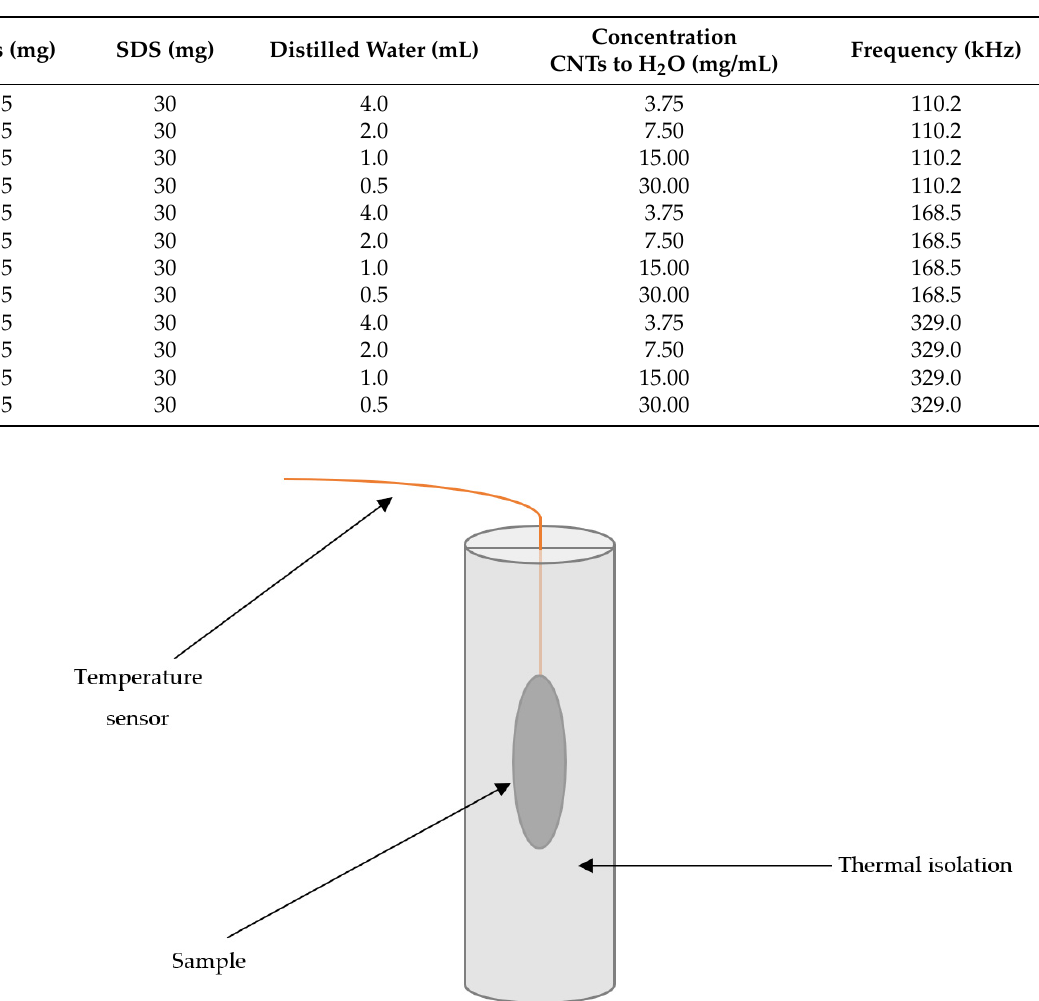
Table 1. The ratio of components in samples with CNTs.